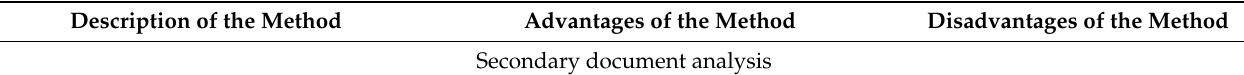
Table 2. Advantages and disadvantages of the